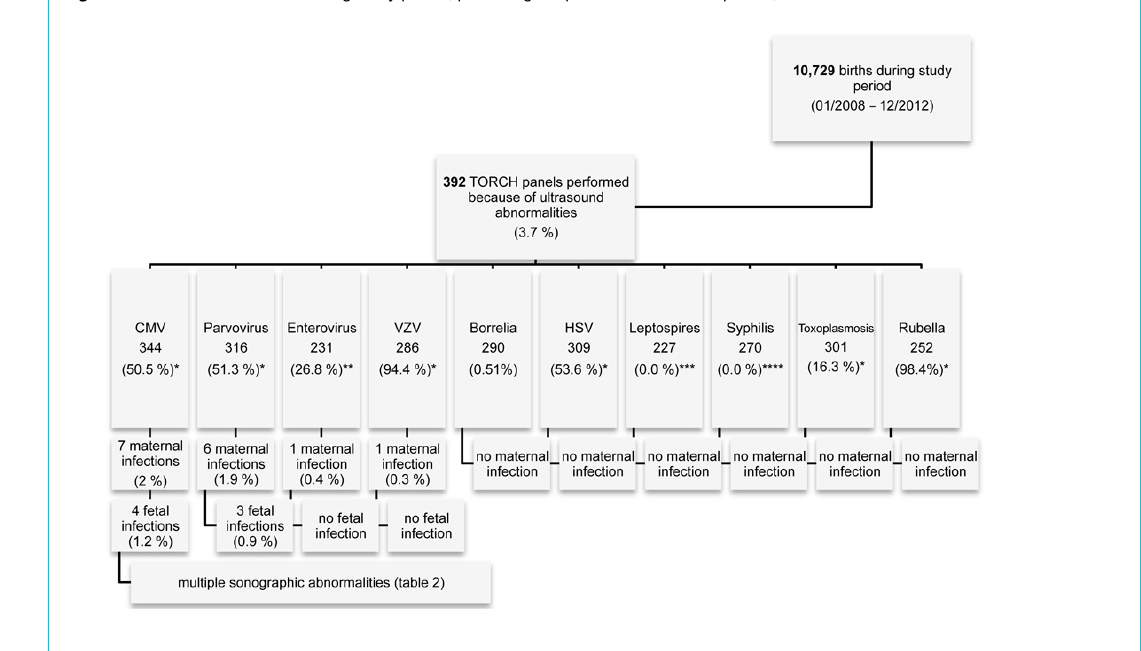
Figure 1: Total amount of births during study period, percentage of performed STORCH panels, incidence of maternal and fetal